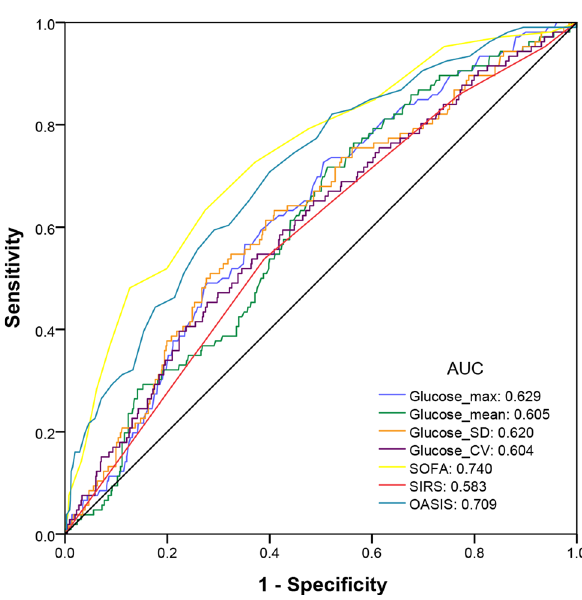
Figure 2. Receiver operating characteristic curves for the prediction of in-hospital mortality in patients with acute